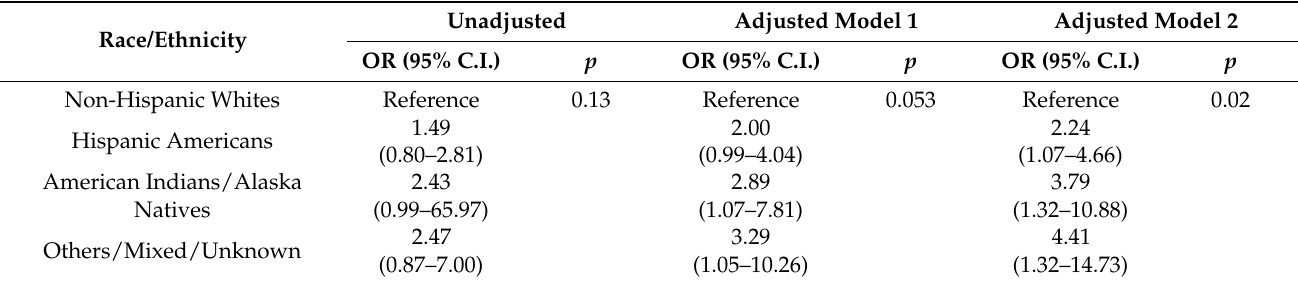
Table 4. Association between race/ethnicity and odds of